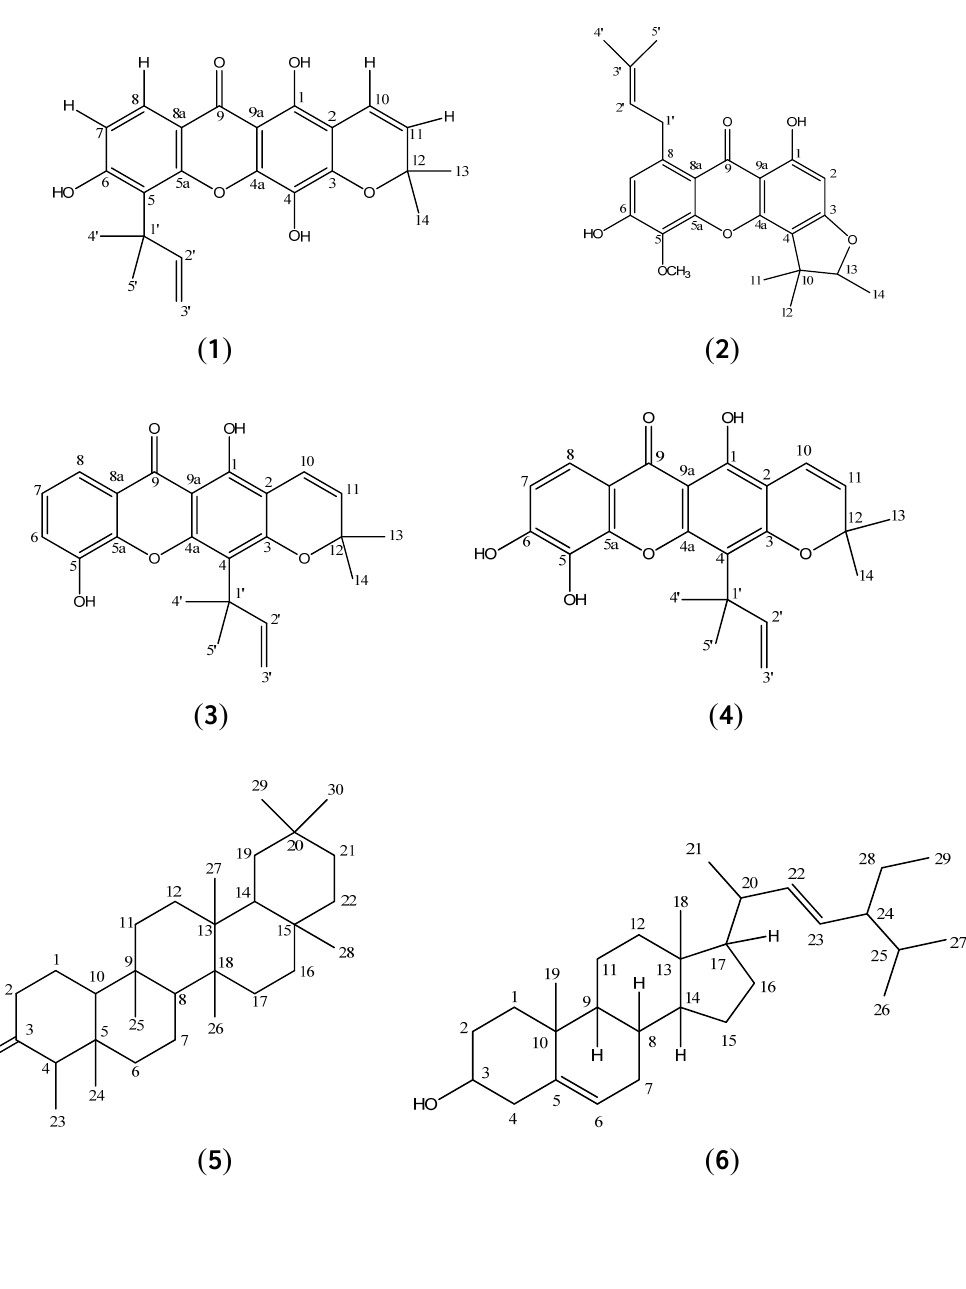
Figure 2. Structures of soulattrin ( 1 ), caloxanthone B ( 2 ), caloxanthone C ( 3 ), macluraxanthone ( 4 ), friedelin ( 5 ) and stigmasterol ( 6